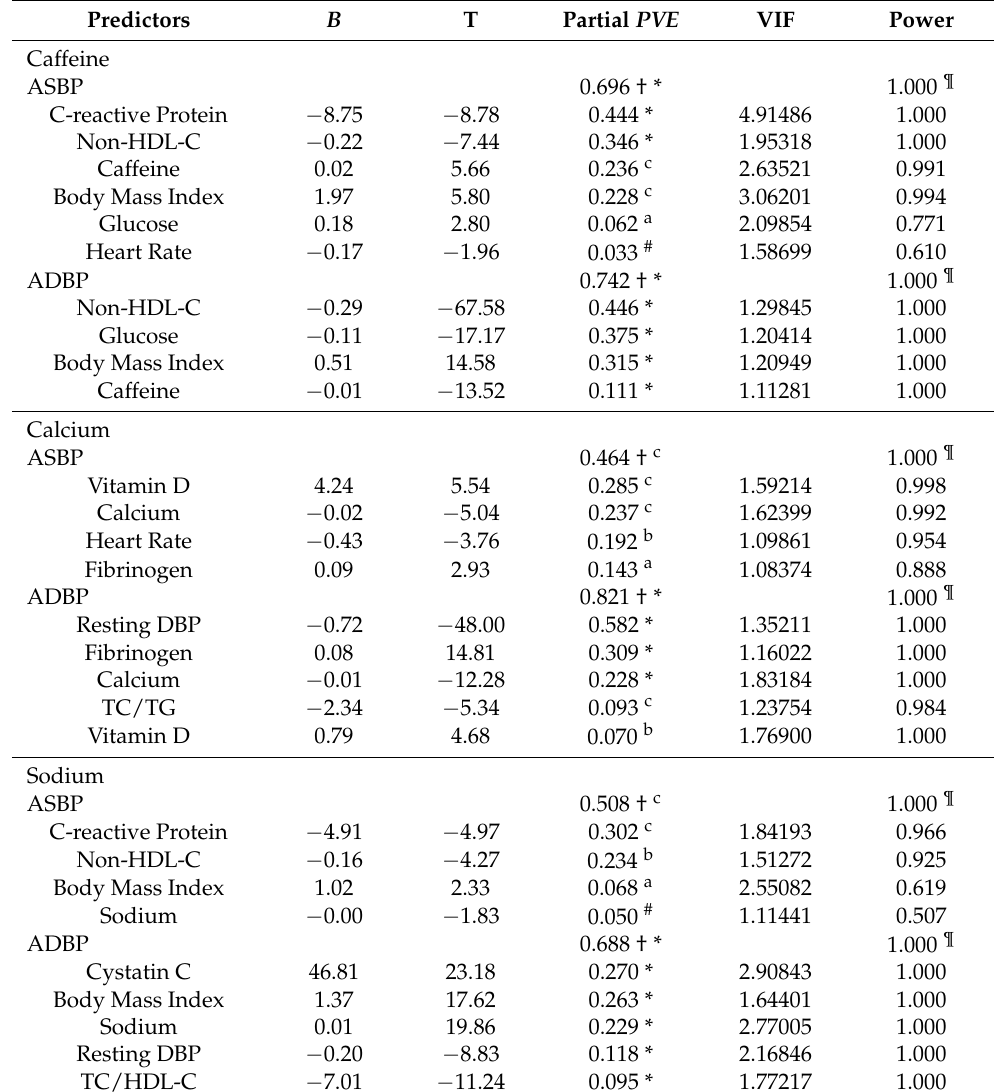
Table 4. The Proportion of Variance Explained in the Linear Mixed Models for the ASBP and ADBP Response to GEST vs. CONTROL over 19